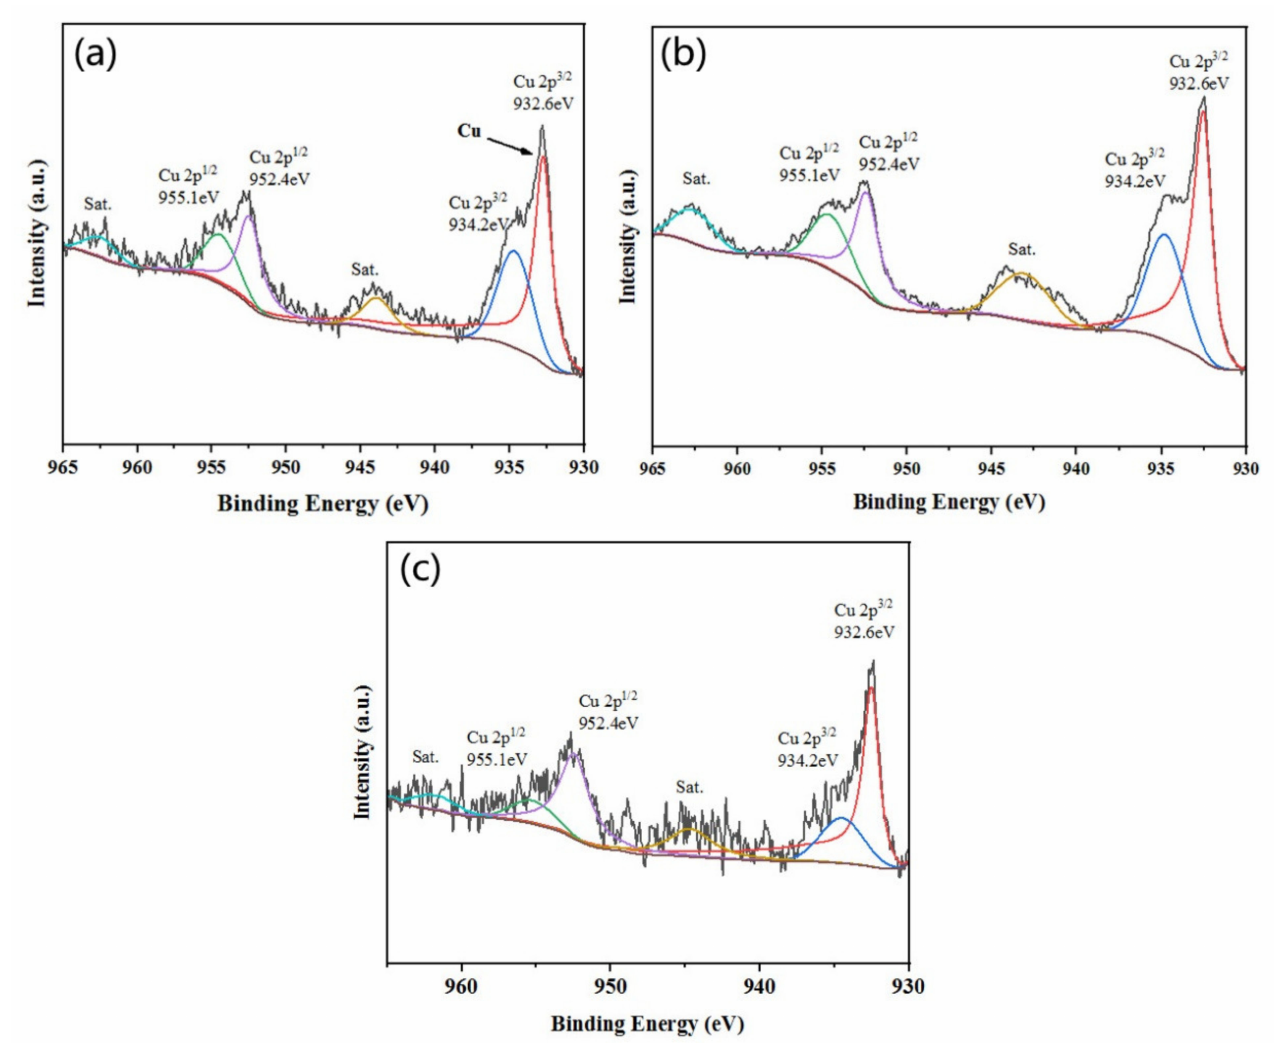
Figure 5. The Xps analysis of ( a ) copper foam (no reaction), ( b ) copper foam (after one reaction), and ( c ) copper foam (after five